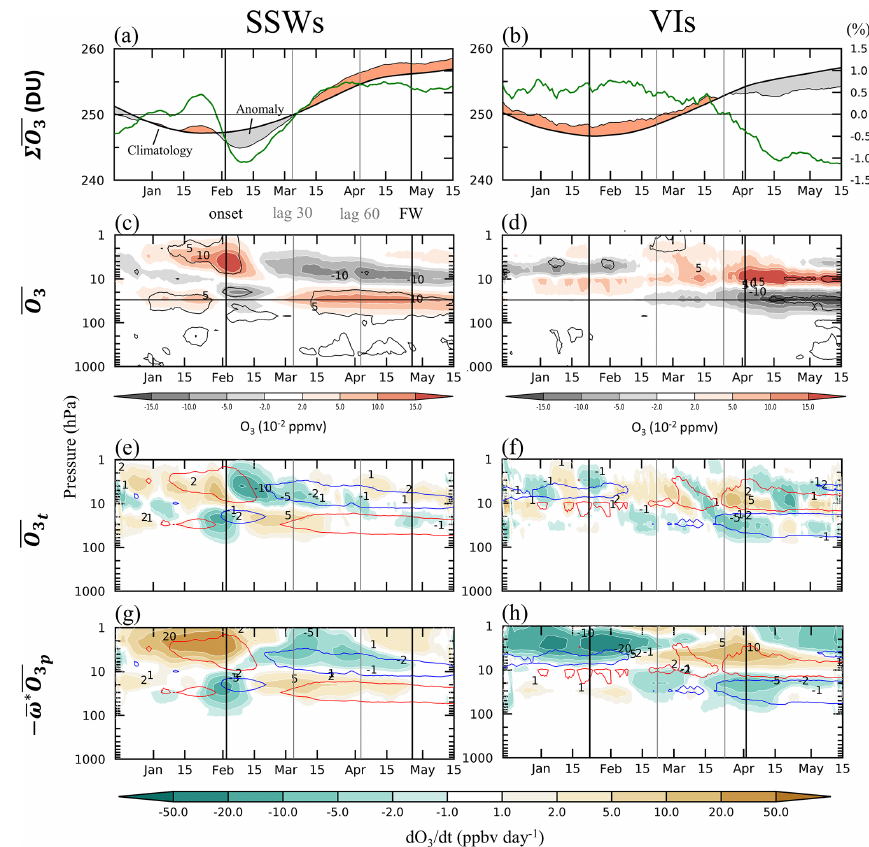
Figure 5. As in Fig. 2, except for tropical ozone ( ± 15 ◦ ) and the exclusion of the eddy flux convergence term. Contours in panels (e) – (h) are the ± 0 . 05ppmv ozone anomalies from panels (c) – (d)